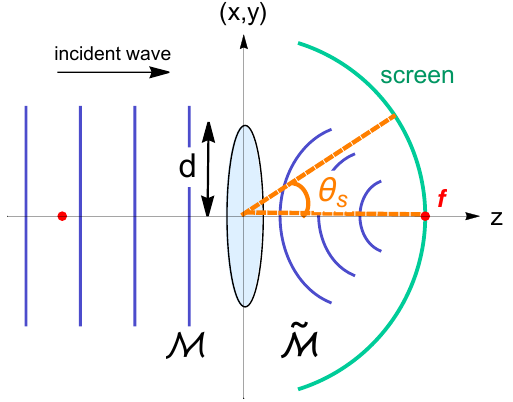
Figure 3 . A virtual wave optical system, where the lens is located at { ( x L , y L ) ≡ ( x, y, 0) | x 2 + y 2 ≤ d 2 } , and the screen is located at { ( x s , y s , z s ) ≡ ( x, y, z ) | x 2 + y 2 + z 2 = f 2 , z ≥ 0 }